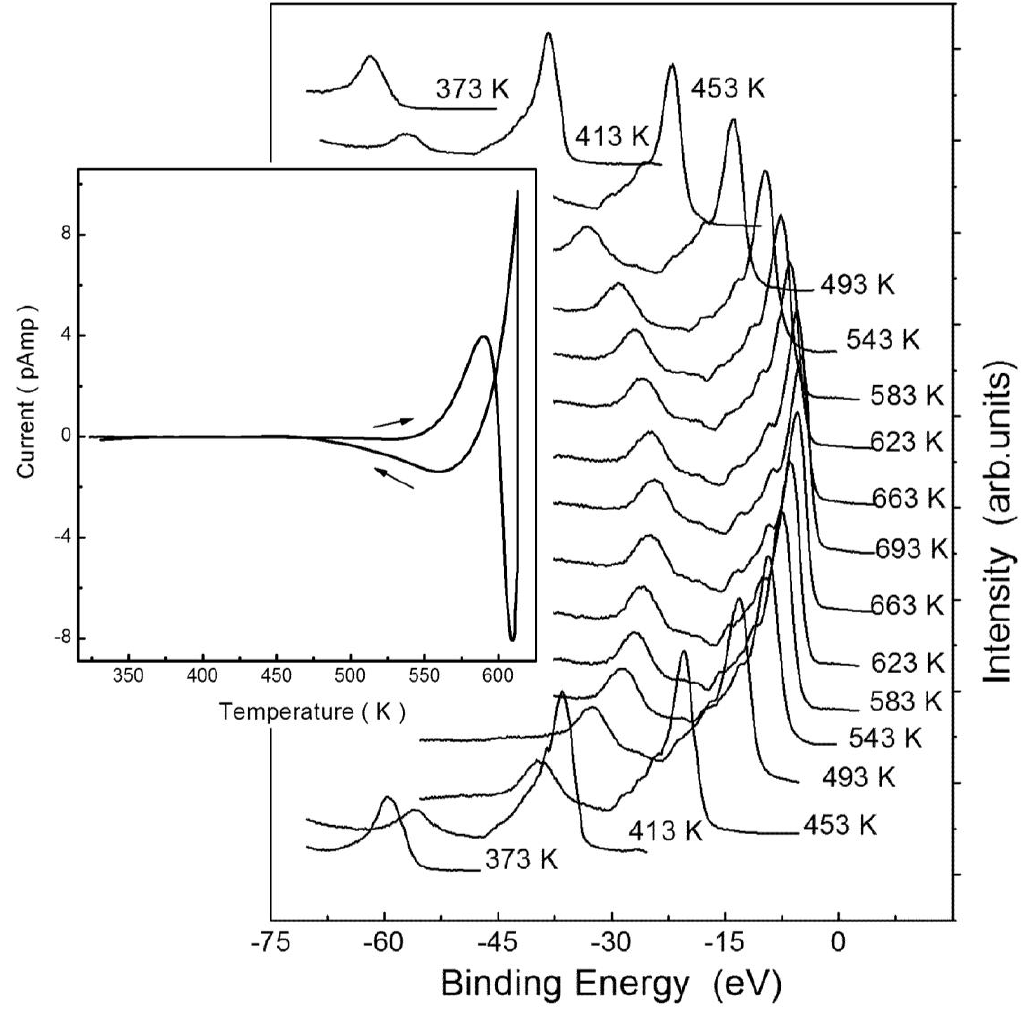
Figure 8. The photoemission spectra from Li temperatures in a heating-cooling cycle (from bottom to top). The photoemission spectra were taken at a photon energy of 56 eV with electrons collected along the surface normal. The measured currents, due to trapped charges, in the [110] direction of lithium tetraborate single crystal with increasing and decreasing temperature (as indicated) in the region of 300 to 600 K are shown in the inset. Adopted from